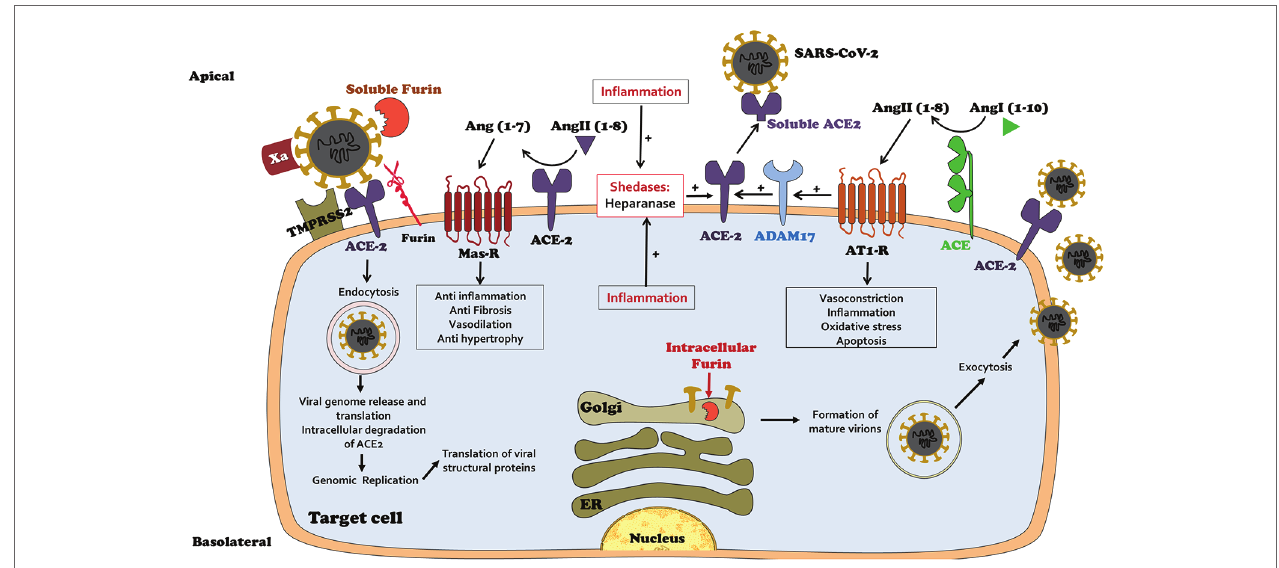
FIGURE 2 | Physiology of coronavirus disease 2019 (COVID 19) homing to target host cells expressing ACE2: viral spike-domains enable attachment to cell- membrane-bound ACE2. Attachment is further enabled by furin, corin, TMPRSS2, and Factor Xa. Following attachment the virus undergoes internalization and replication in host cells, a process associated with degradation of internalized ACE2. Ang 1-7 synthesis consequently declines. Unopposed Ang II action triggers inflammation which activates ADAM 17, leading to shedding of membranal ACE2, further depleting cell-bound ACE2 and local Ang 1-7 synthesis. Viral attachment to target host cells may be attenuated by its competitive binding with rising titers of circulating